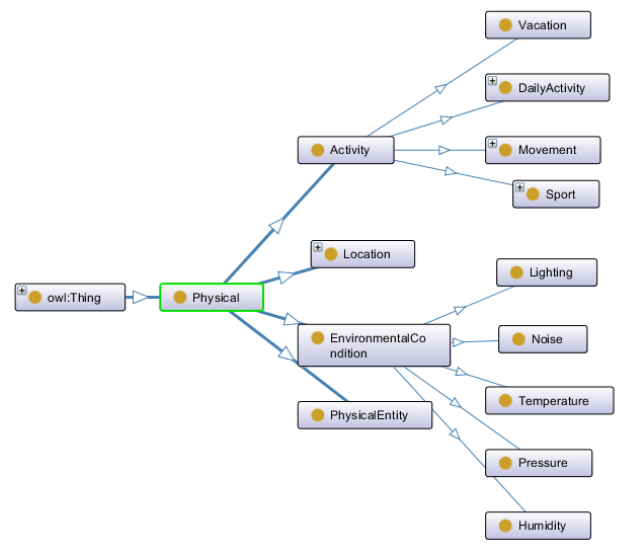
Figure 2. Physical Context